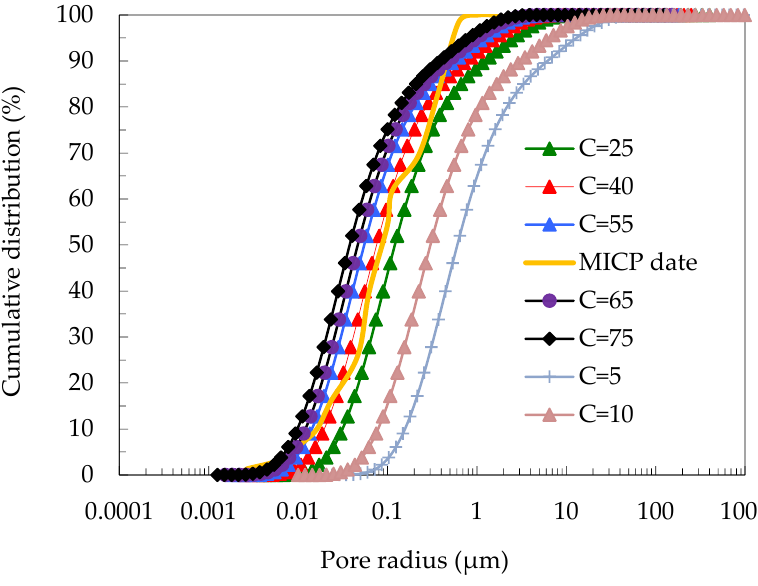
Figure 2. Coefficient C fitting curve.